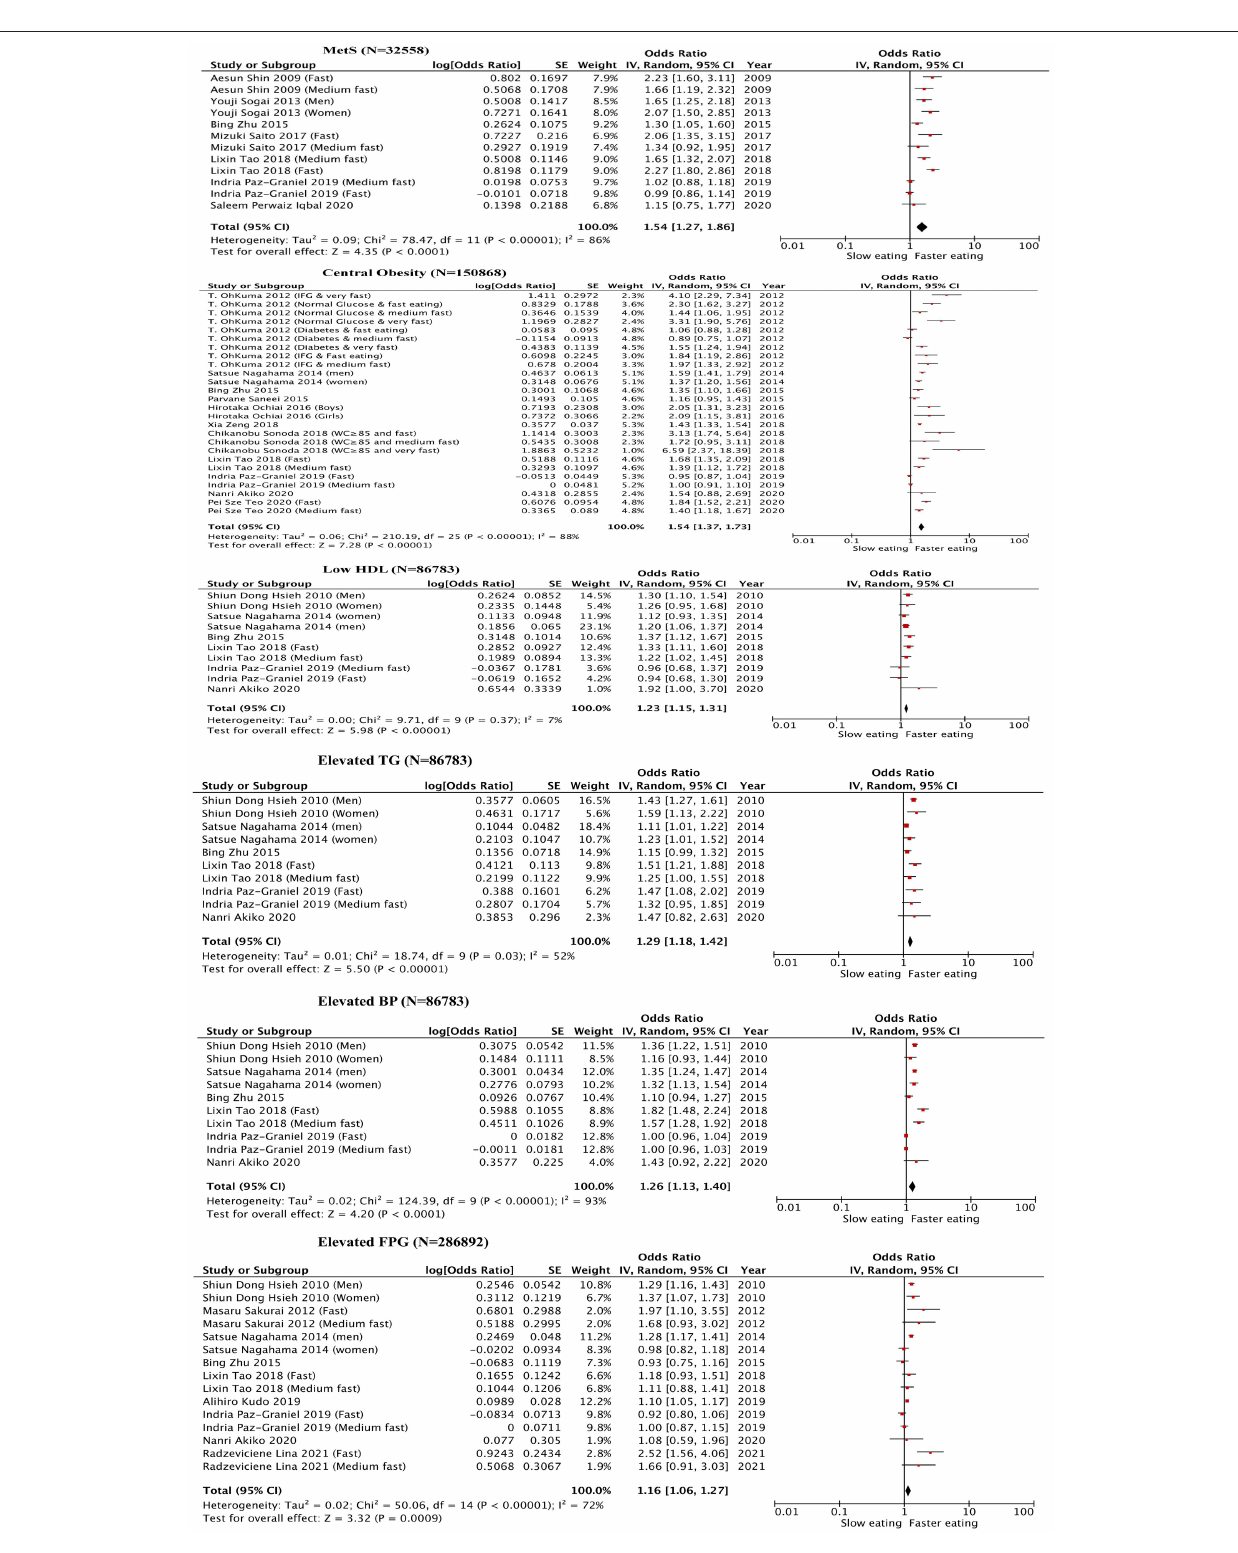
Frontiers in Nutrition |